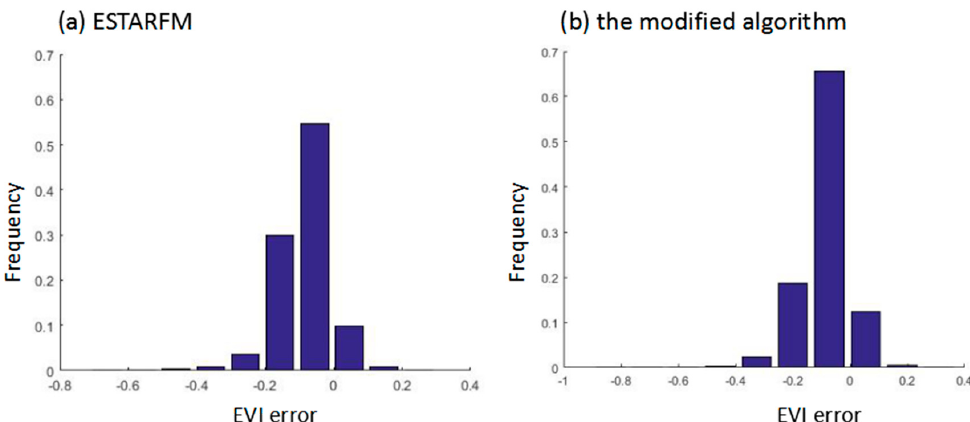
Figure 10. Frequency statistics histogram of EVI error of images predicted by ESTARFM ( a ) and the modified algorithm ( b ) for paddy rice in the study area.